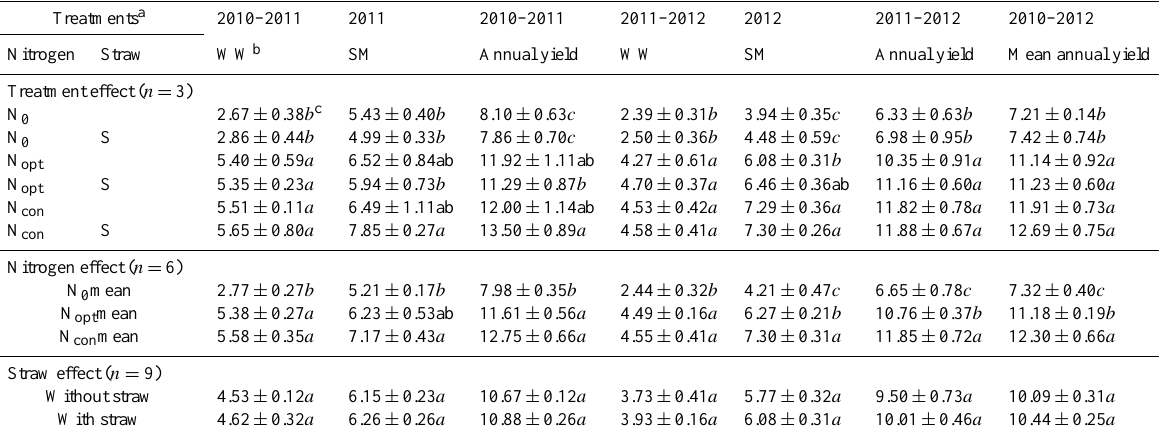
Table 3. Grain yield (dry matter, Mgha − 1 ) in winter wheat–summer maize double-cropping system from October 2010 to October 2012. Treatments